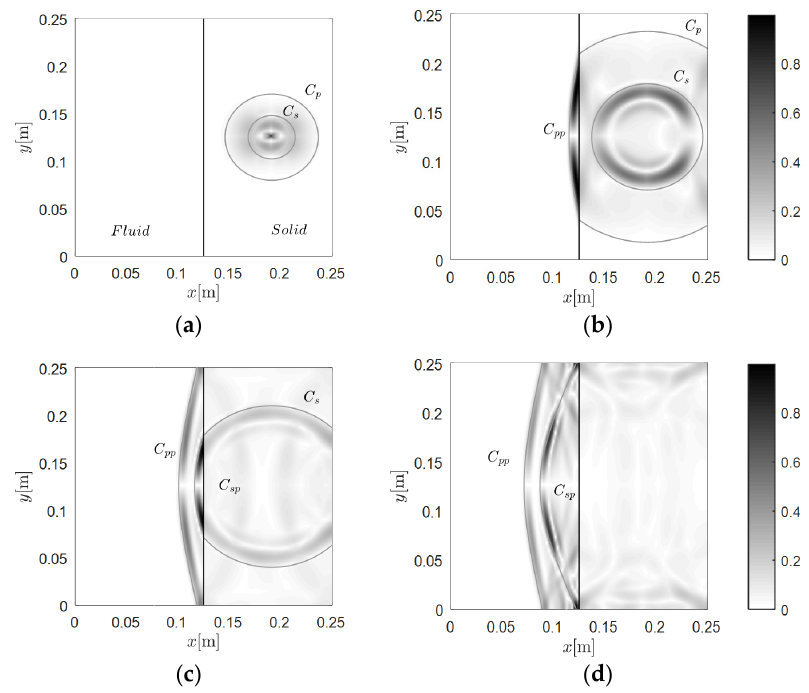
Figure 3. Snapshots of the wavefield induced by the source at 0.191 m and 0.125 m in the solid region: